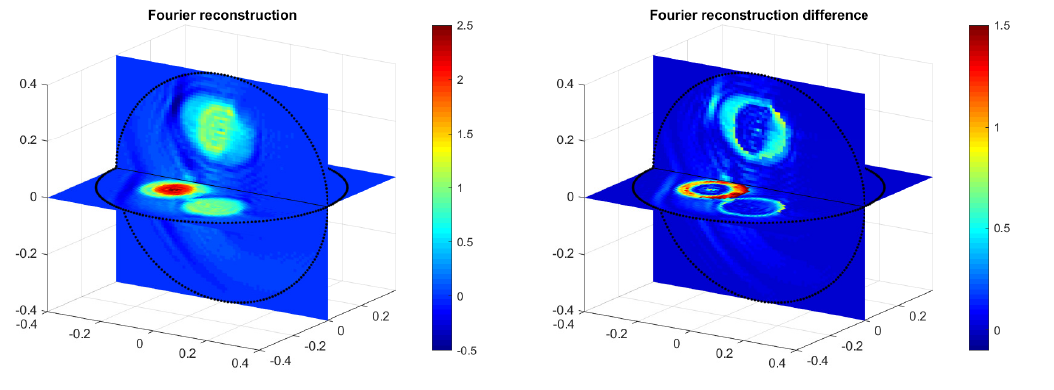
Figure 6. R ECONSTRUCTION f rec ( LEFT ) AND THE DIFFERENCE | f rec − f (cid:63) | ( RIGHT ) USING THE F OURIER ALGORITHM . Note that the Fourier algorithm assumes constant sound speed c 0 in the image reconstruction, similar to the results shown in the bottom row of Figure 5.